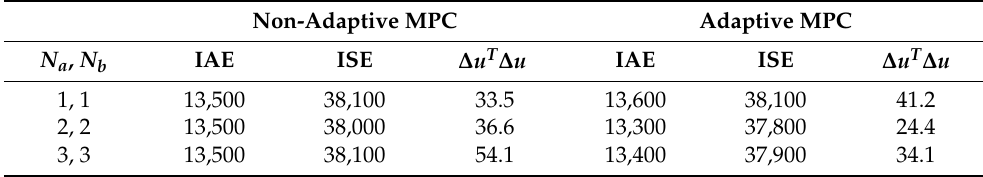
Table 6. The controller performance criteria for a 30% disturbance in the cell death